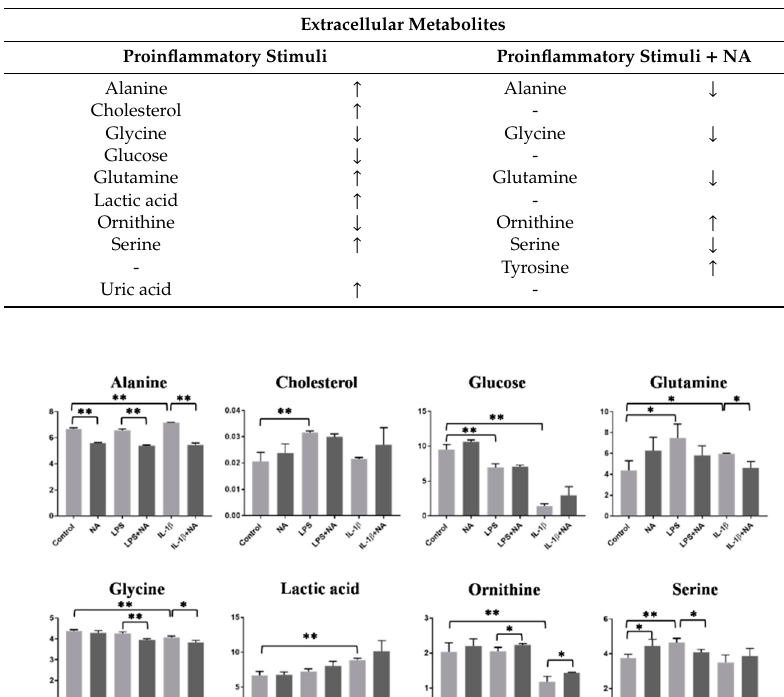
Figure 5. Relevant metabolic pathways that were found significantly altered after treatment with proinflammatory stimuli (LPS and IL-1 β ) ( a ) and after treatment with proinflammatory stimuli in combination with NA ( b ) in Caco-2 cells at the intracellular level. Increased and decreased metabolites are highlighted in red and green, respectively.